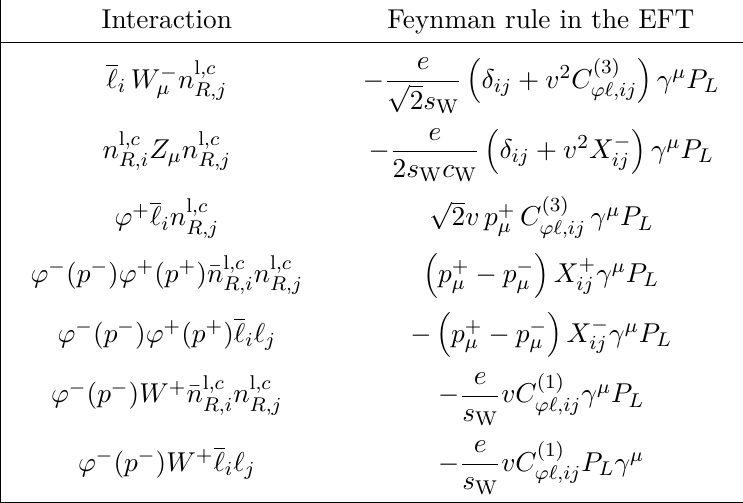
and X − are given in eqs. (3.9) and ij ϕ‘,ij